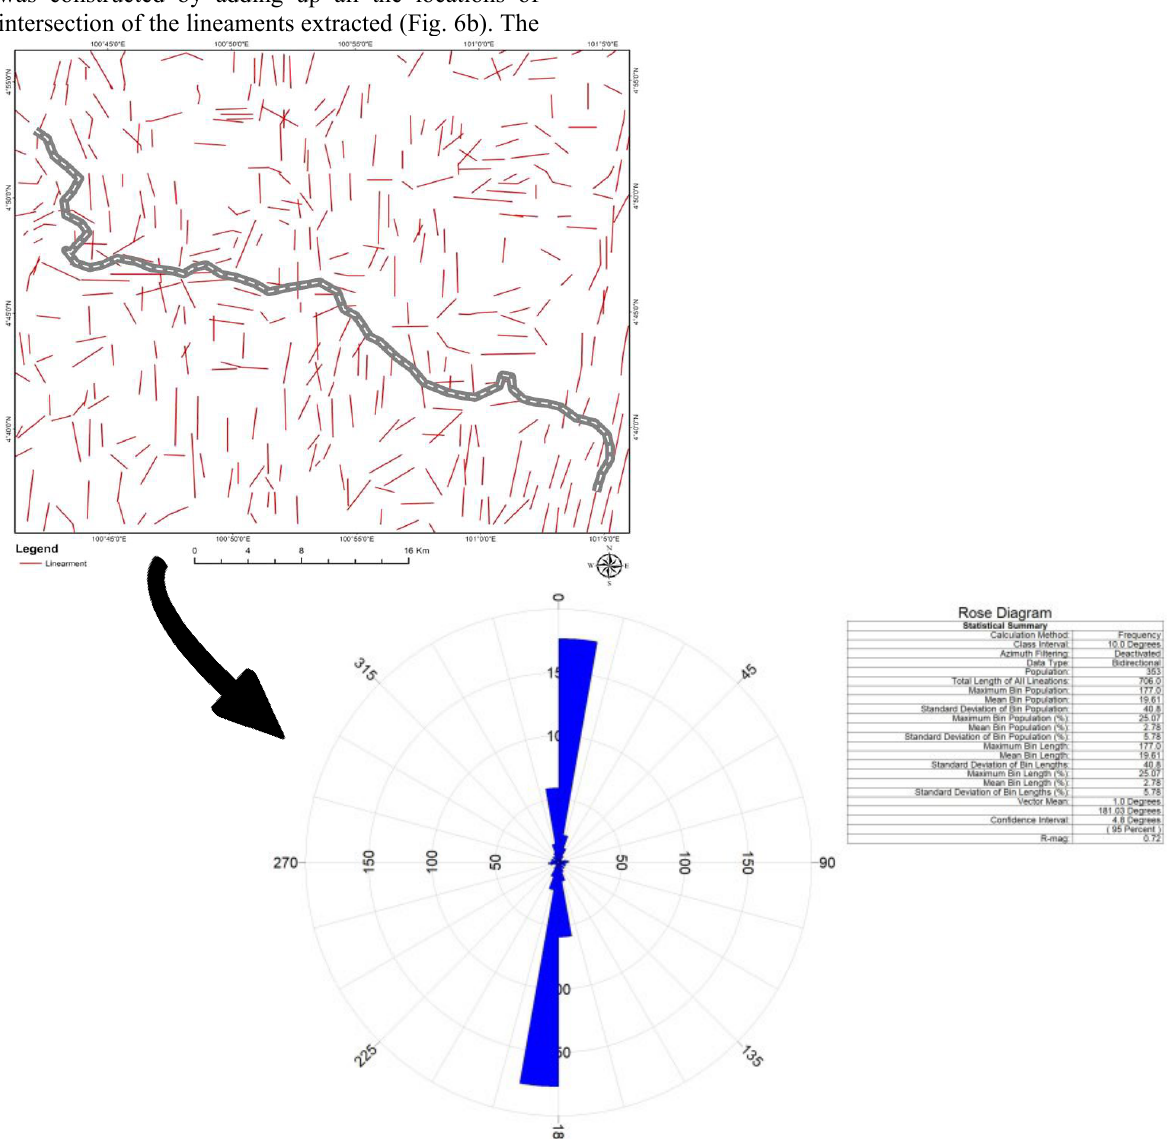
Figure 5: (a) Different directions of geological lineaments generated from satellite data (b) Lineament orientation showing prevalence of NE–SW directions acquired by different filters as shown in a rose